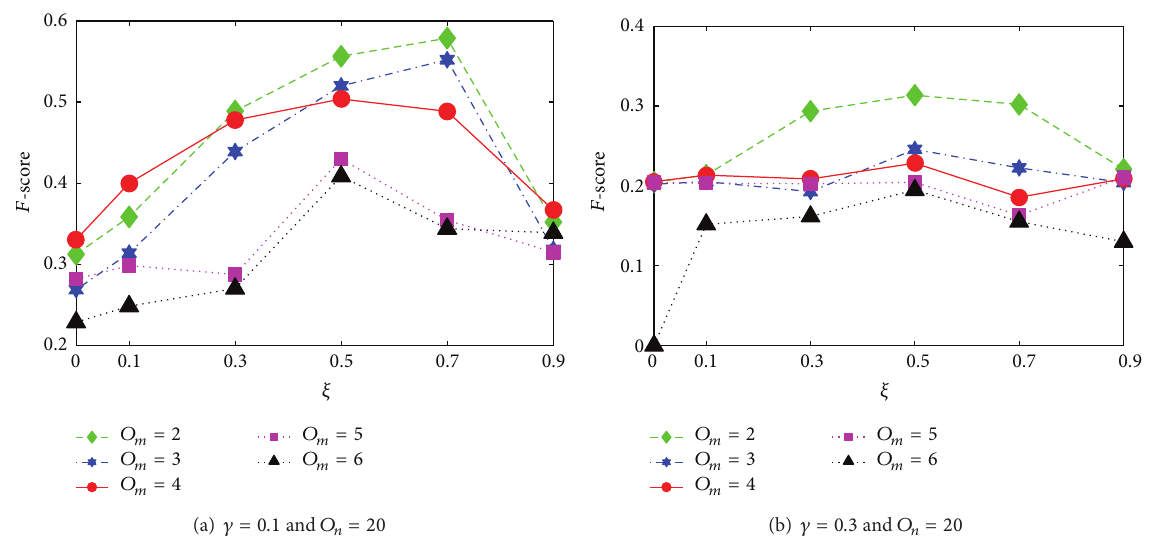
Figure 3: Analysis of threshold value 𝜉 of MRLD in terms of 𝐹 -score.